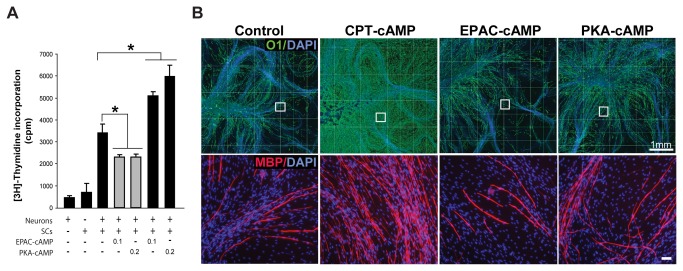
Effect of selective activation of EPAC and PKA on the proliferation and differentiation of SCs in co-culture with DRG neurons.SC-DRG neuron cultures were left untreated (control) or stimulated with CPT-cAMP, EPAC-cAMP or PKA-cAMP (200 µM each, unless otherwise indicated) for 3 days (A) or 12 days (B) prior to analysis by [3H]-thymidine incorporation (A) and immunofluorescence microscopy (B), respectively. Experimental conditions and analysis were identical to those of Figure 4. In B, images of myelinating co-cultures are shown at low (top panels) and high (bottom panels) magnifications, respectively. EPAC-cAMP significantly reduced proliferation of axon-contacting SCs (A). However, it did not mimic the effect of CPT-cAMP and db-cAMP (not shown) on inducing the formation of myelin sheaths (B). The strong pro-differentiating effect of CPT-cAMP is reflected by the occurrence of O1 positive, MBP positive cells throughout the co-culture system (B).